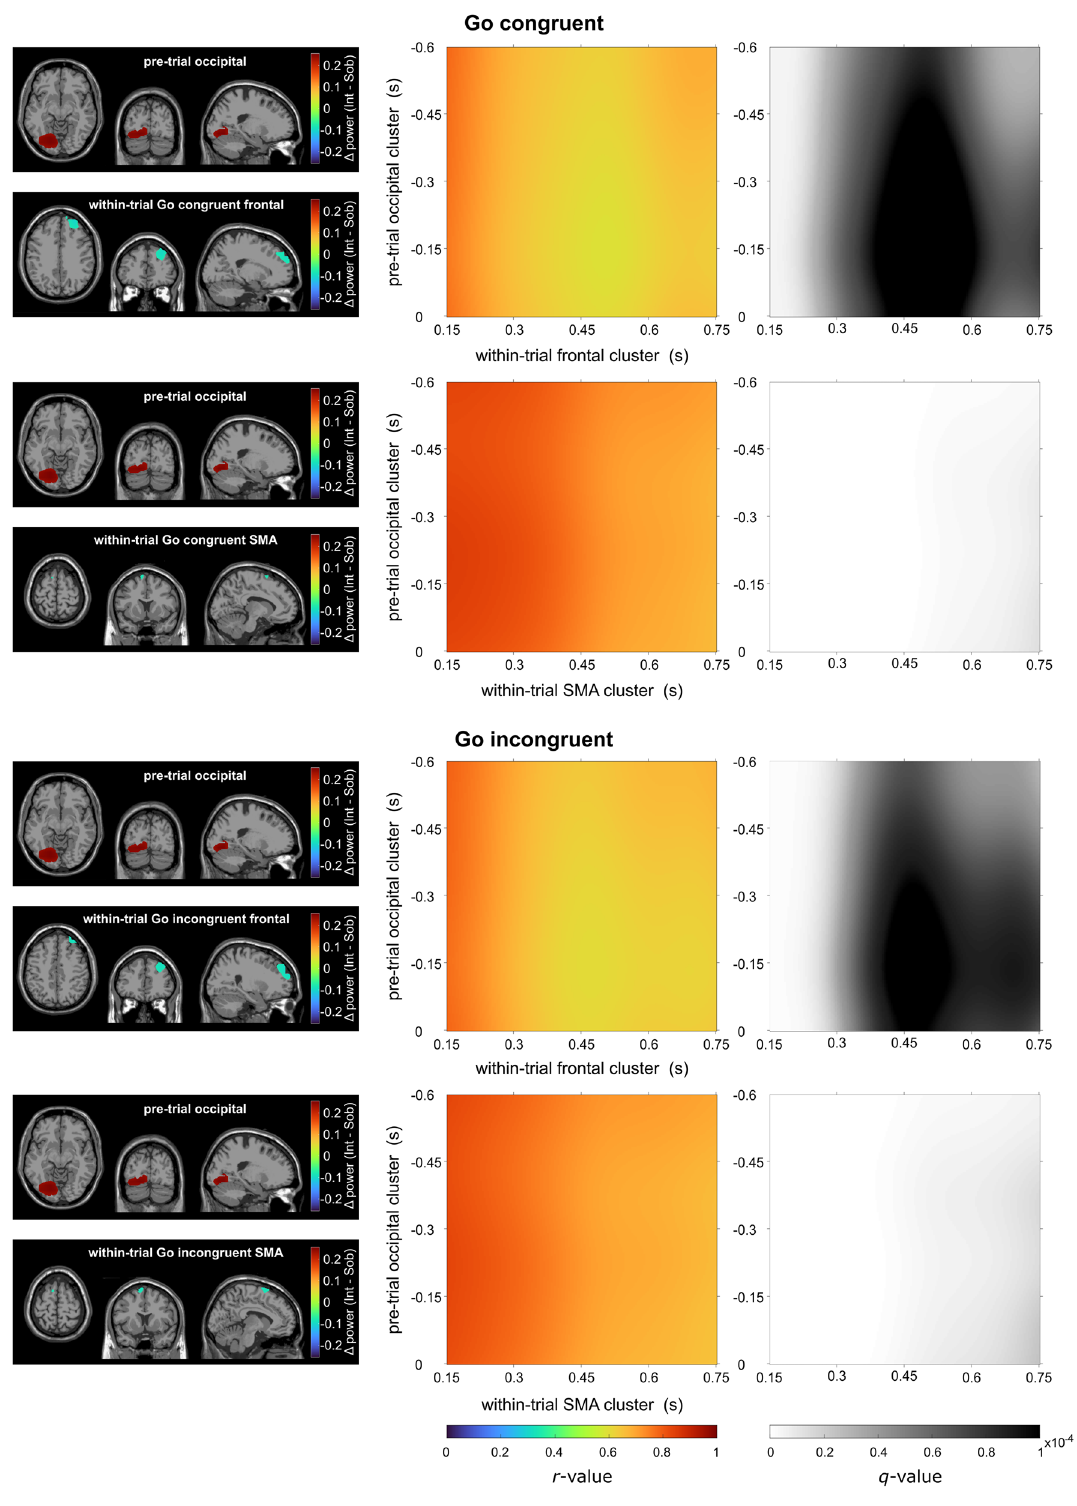
Figure 3. Illustration of the intoxication effect in Go trials on the neuroanatomical source level. The left column depicts the brain areas underlying significant changes in theta band activity in the pretrial time window (occipital; intoxicated > sober) and within-trial time window (frontal and SMA, intoxicated < sober). The middle column depicts the correlation coefficient for the correlation between the theta band intoxication effects in the pre-trial (y-axis) and within-trial (x-axis) clusters which are depicted on the left. The right column depicts the associated significance value q (the FDR-corrected p value of each correlation), with brighter colors indicating a higher